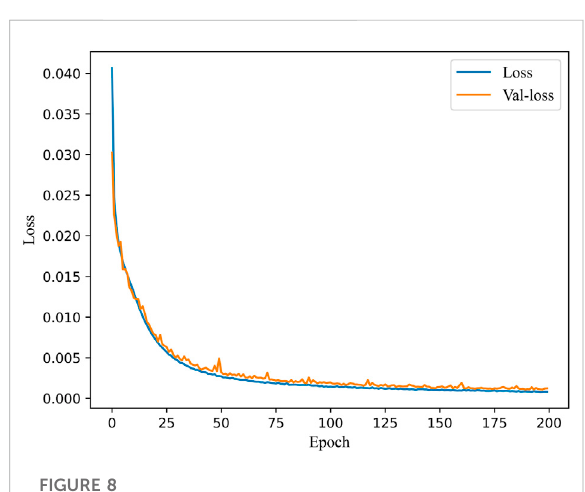
FIGURE 8 Loss versus epoch after fl ight altitude being added as